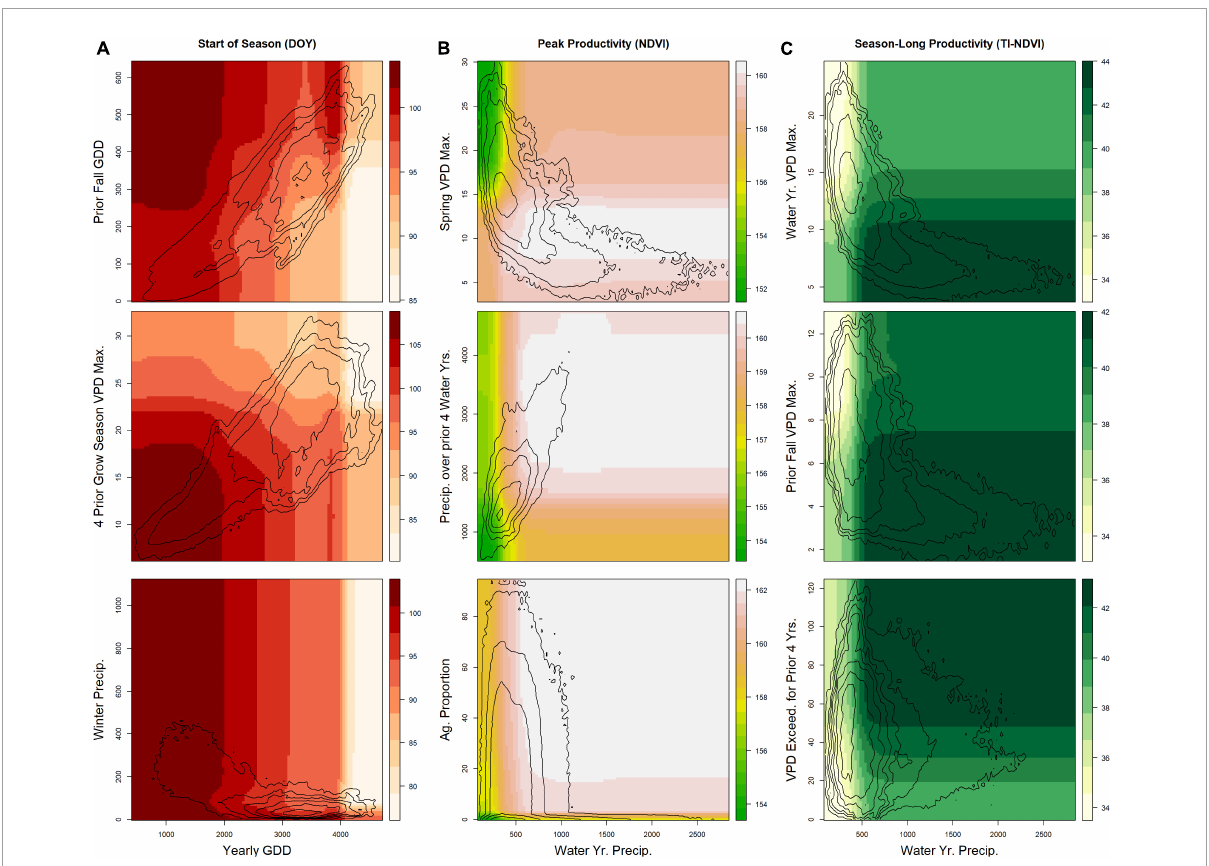
FIGURE5 Results from the final random forest models for areas of the U.S. Northwestern Plains having primarily grassland land cover pixels. For each phenological measure, three partial-dependence plots show the relationship between selected pairs of variables. Contour lines show the natural logarithm of the kernel density (i.e., the distribution of the two variables in the dataset). Seasonal and yearly variables represent either (A) the mean over the time period for temperature ( ◦ C, Temp.) and vapor pressure deficit (hPa, VPD), (B) the cumulative sum for precipitation (mm, Precip.), or (C) exceedance of vapor pressure deficit (days over 1 or 2 times the SD of the long-term distribution) and growing degree-days ( ◦ C, GDD). Max, Maximum; SD, standard